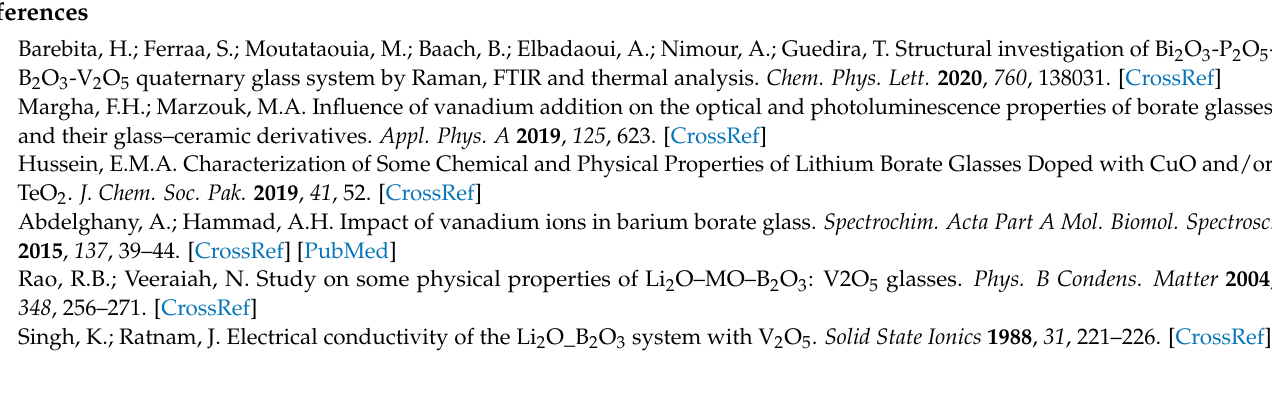
samples. Figure S2: Raman spectrum for all the glass samples. Figure S3: Diborovanadates